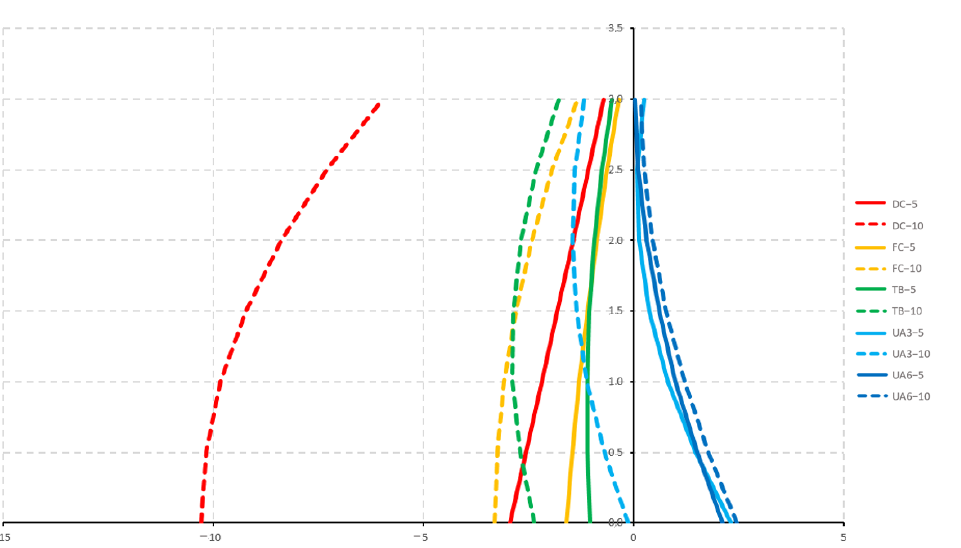
Figure 9. Sagittal forces generated by the arch-formed configurations (see Figure 2) during deactivation (protrusive; positive values; retrusive: negative values). Tested cantilever configurations origin from Figure 2.